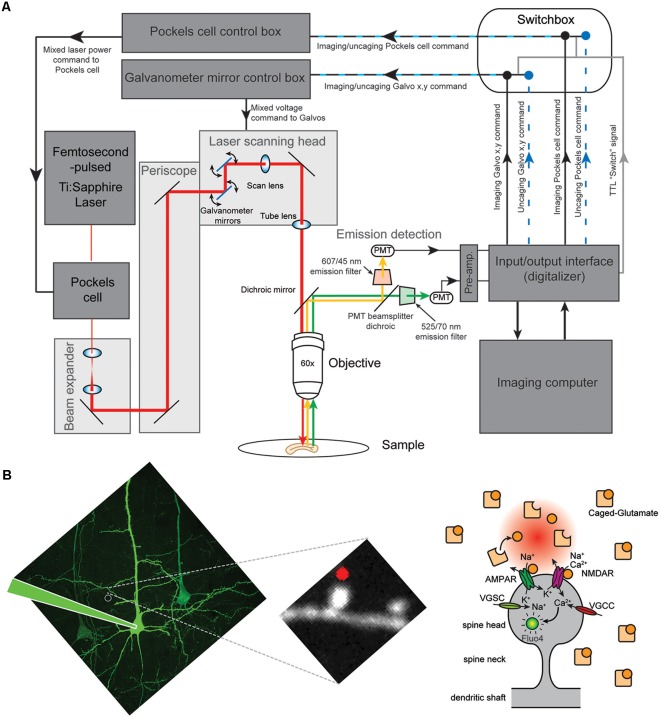
Two photon uncaging of caged glutamate at single spines of layer 5 (L5) pyramidal neurons. (A) Schematic illustration of the custom imaging system. A customized high-speed electronics module by Bruker (formerly Prairie Technologies) is integrated between the input/output interface and the laser scanning control boxes to rapidly switch (in less than 2 ms) between the command strings (imaging or photoactivation mode) being routed to the control boxes. The module is fully integrated with the imaging software and allows synchronized photoactivation (uncaging), imaging and electrophysiology. This gives the ability to set-up sophisticated experimental protocols in a user-friendly manner using a single laser source and scanning system. (B; Left) Two-photon (2P) image of a L5 pyramidal neuron from V1 cortex and a zoomed in image of a piece of dendrite showing the spines. (Right) Cartoon drawing of a dendritic spine. AMPAR, AMPA receptor; NMDAR, NMDA receptor; VGSC, voltage-gated sodium channel; VGCC, voltage-gated calcium channel.